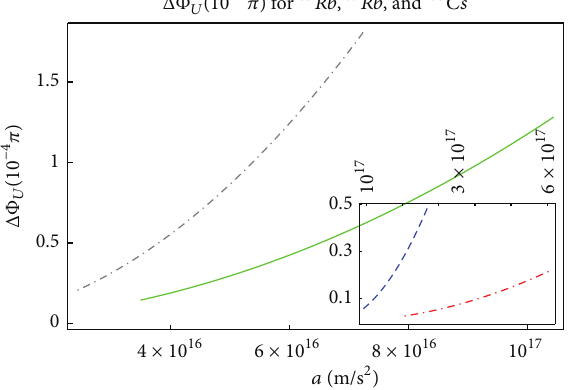
Figure 1: Plots of ΔΦ 𝑈 as a function of the atom acceleration 𝑎 , for time intervals 𝑡 ≃ 1 /𝜔 0 and the splitting between the hyperfine energy levels: main pictures: (gray) dot dashed line: 87 𝑅𝑏 , 5 2 𝑃 1 / 2 line, splitting for 𝐹 = 1 → 𝐹 = 2 transition ( 𝜔 0 = 814 . 5 MHz, = 36 . 129 MHz [53]); (green) solid line: 133 𝐶𝑠 , 6 2 𝑃 𝛾 0 1 / 2 line, splitting of the between the 𝐹 = 3 and 𝐹 = 4 levels ( 𝜔 0 = 1167 . 68 MHz, = 28 . 743 MHz [54]). Pictures in the inset: (blue) dashed line: 𝛾 0 85 𝑅𝑏 , 5 2 𝑆 𝐹 = 1 and 1 / 2 line, energy splitting between the levels = 3 . 035 GHz, 𝛾 = 36 . 129 MHz for 𝐷 𝐹 = 2 ( 𝜔 0 0 1 transition, = 38 . 117 MHz for 𝐷 𝛾 0 2 transition [52]); (red) dot dashed line: 87 𝑅𝑏 , 5 2 𝑆 𝐹 = 1 and 1 / 2 line, energy splitting between the levels = 6 . 843 GHz, 𝛾 = 36 . 129 MHz for 𝐷 𝐹 = 2 ( 𝜔 0 0 1 transition, = 38 . 117 MHz for 𝐷 𝛾 0 2 transition